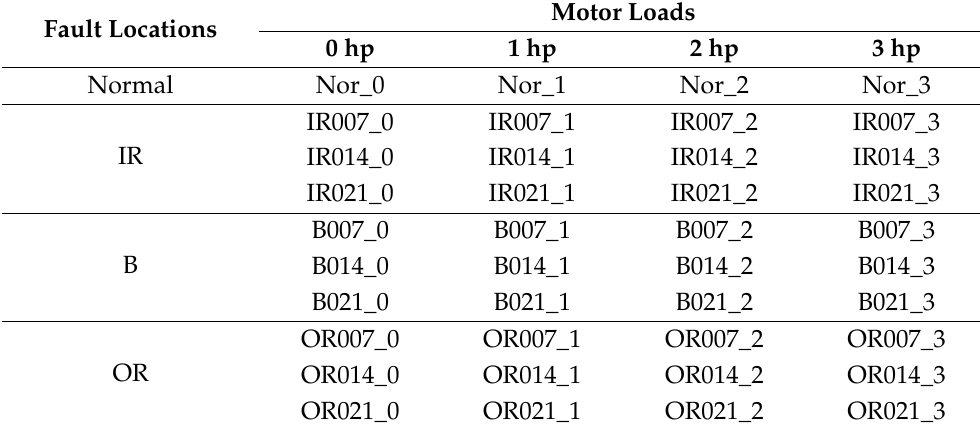
Table 5. Data description of the CWRU dataset.